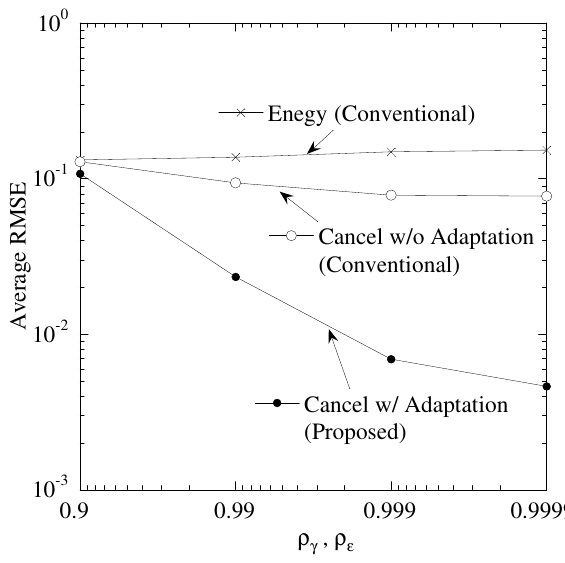
Figure 8. Performance between ρ γ = ρ ε and RMSE.